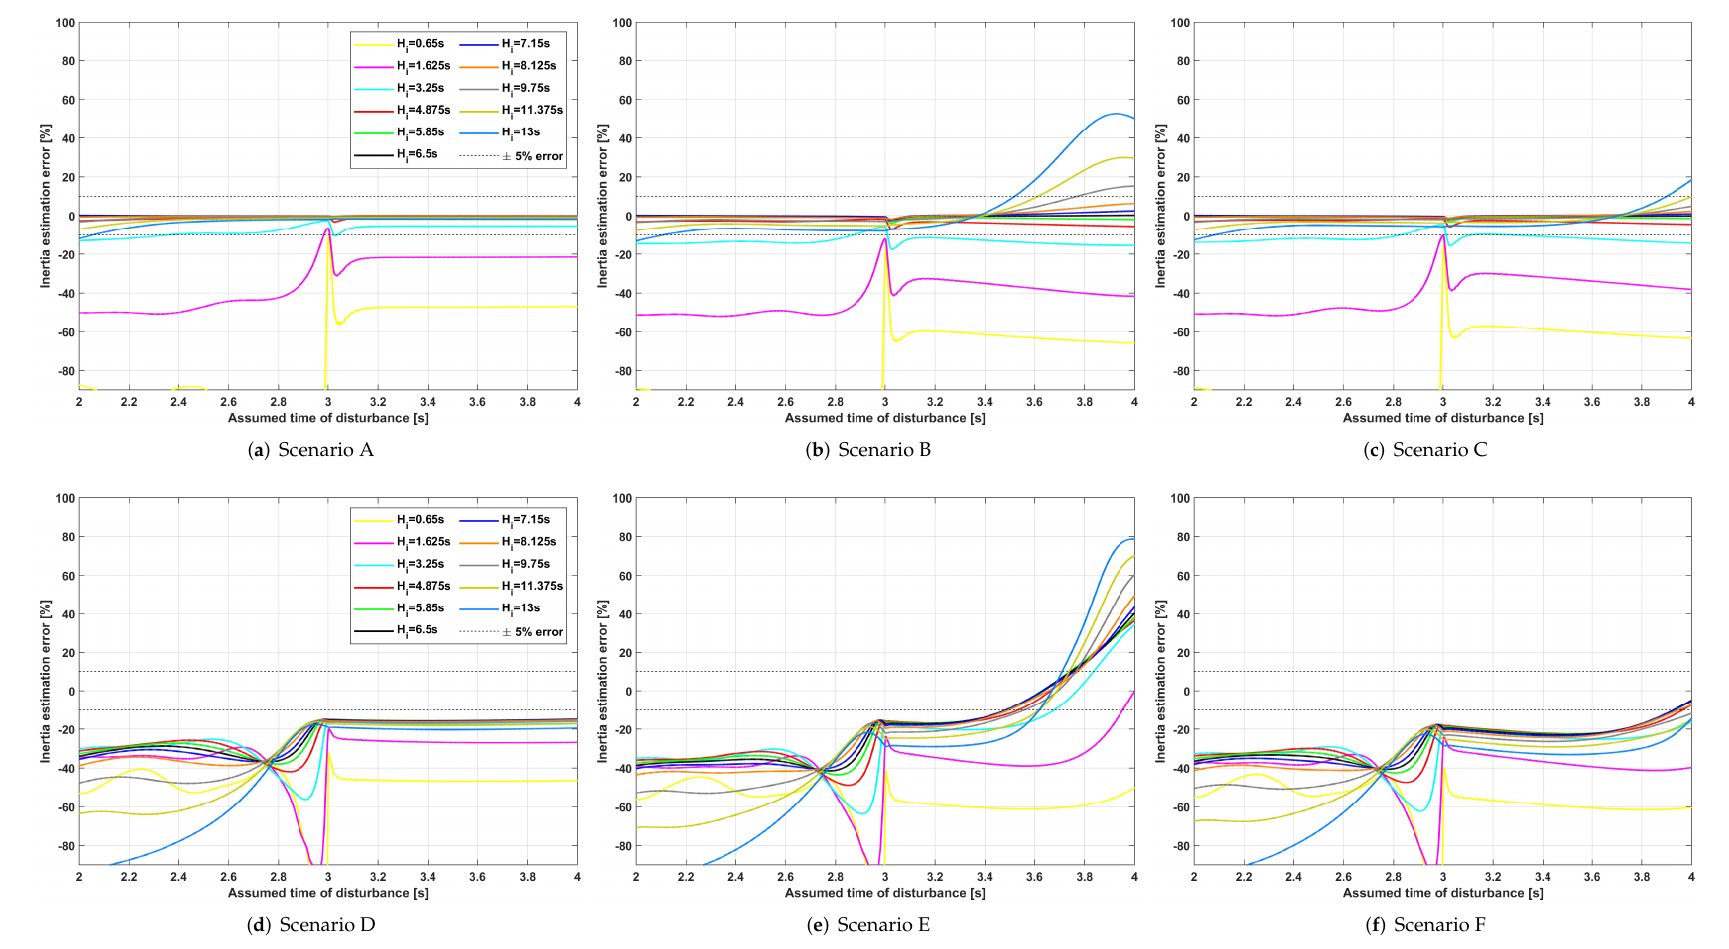
Figure 8. Analysis of the EKF-based inertia estimates to the assumed time of disturbance ( t dur = 2s). The colored curves in each plot refer to the same legend. For the sake of clarity, the legend is only included in the plots where it does not overlap with the